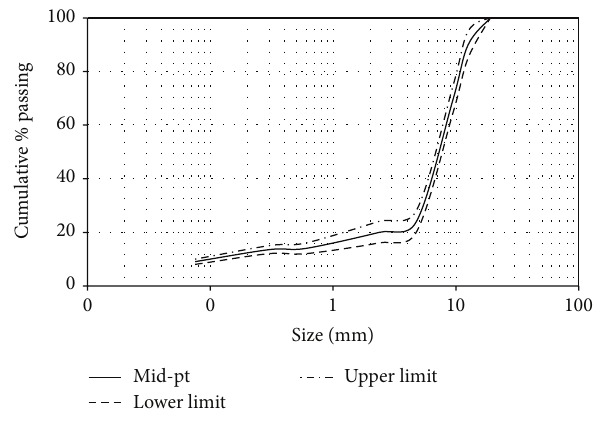
Figure 2: SMA 20 aggregate